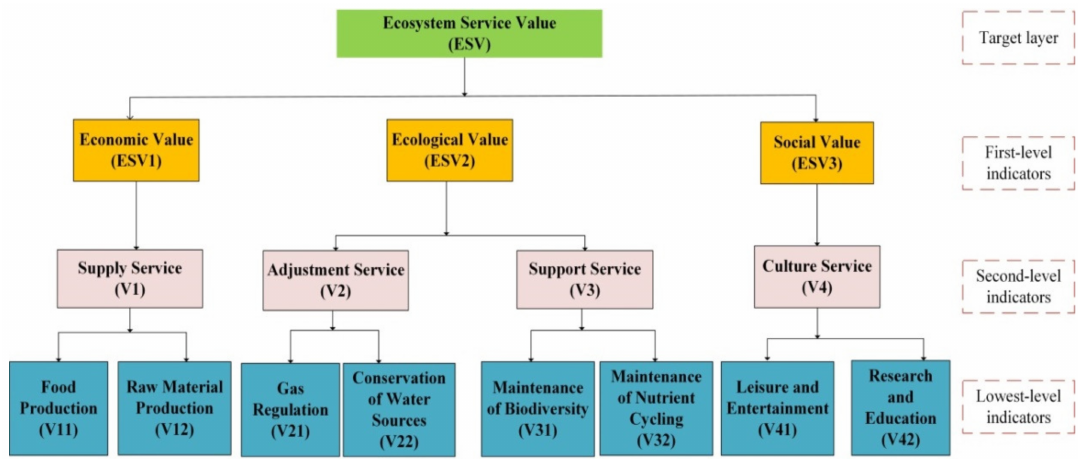
Figure 4. Construction of evaluation index